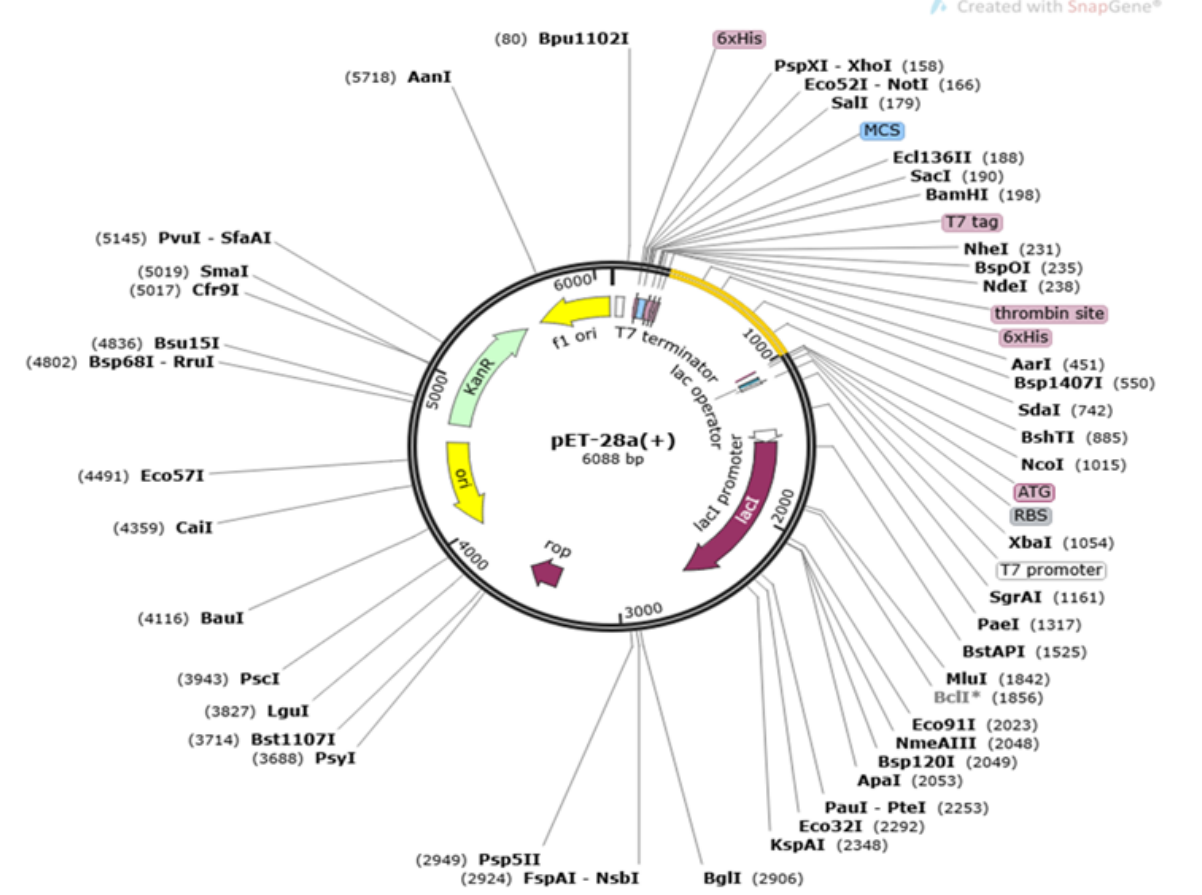
Figure 7. Cloning of multi-epitopes vaccine constructs (yellow color) into pET28a (+) vector.